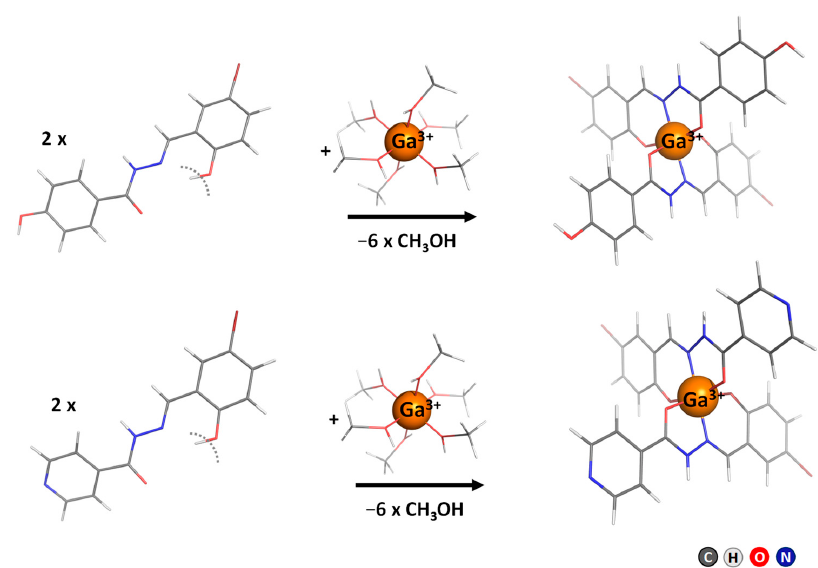
Figure 3. Optimized structures of the ligands and octahedral Ga(III) complexes. Ligands H 2 L 1 and H 2 L 2 are supposed to be able to displace NO (cid:2871)(cid:2879) from Ga(NO 3 ) 3 and − 51.7 and − 46.4 kcal mol − 1 for the reaction with H 2 L 1 and H 2 L 2 , respectively.